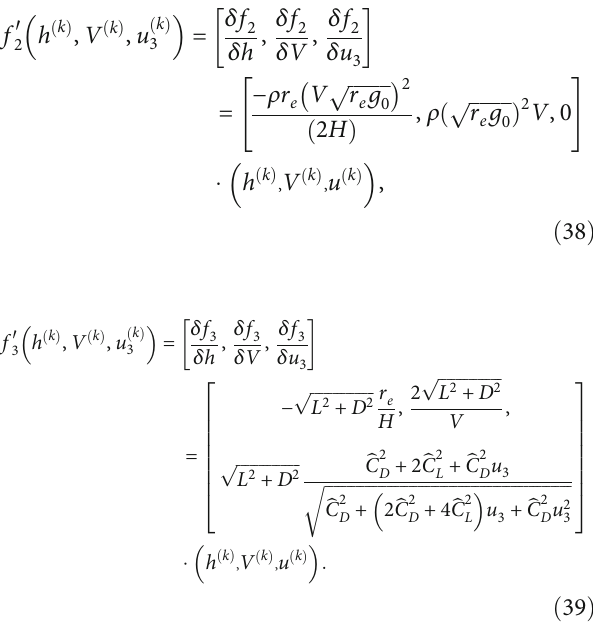
Figure 8: Comparison of fl ight path angle and heading